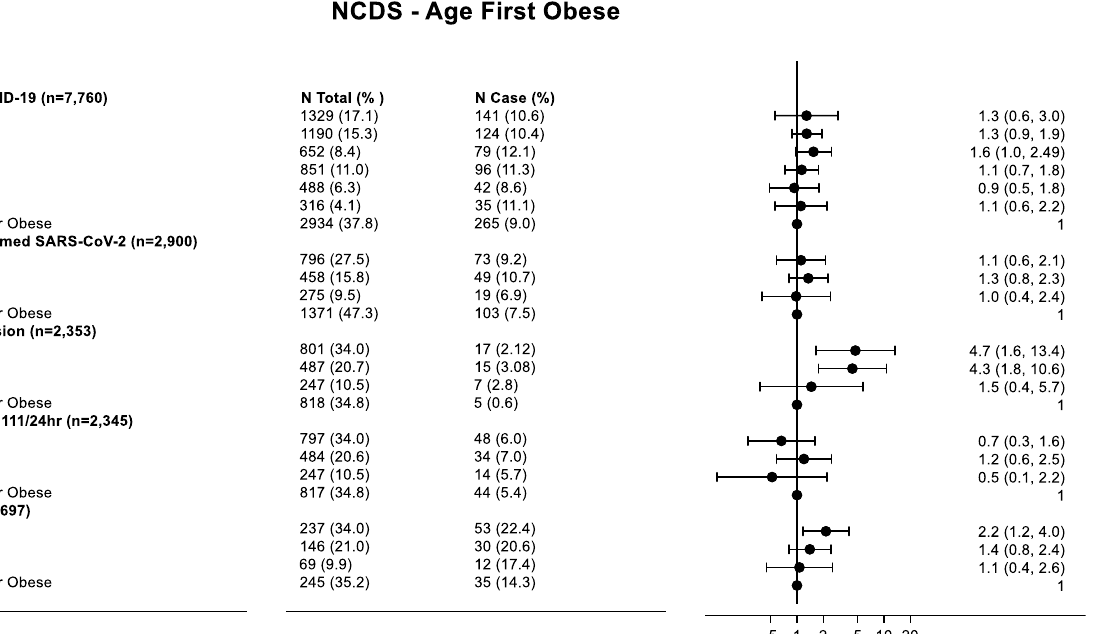
Fig. 2 Forrest plot of adjusted logistic regression coefficients for age first obese and COVID-19 outcomes in NCDS. Analysis is adjusted for sex, social class at birth, housing tenure age 7 and cognitive abil- ity age 11. For self-reported COVID-19 and antibody-confirmed SARS-CoV-2 infection the reference category is “no COVID-19” and “no infection”, respectively. For hospital admission and contact